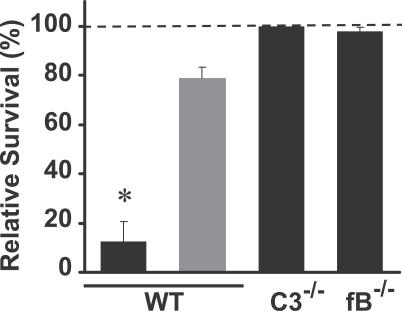

Hi-Enhanced Killing of Sp Requires Opsonization Involving the Alternative Pathway of Complement and Recognition by Mac-1 (CD11b/CD18)Neutrophil-enriched PECs were obtained from mice following i.p. administration of heat-inactivated whole Hi636 in casein. The effect of HKHi on the ability of neutrophil-enriched PECs to kill Sp1121 is shown relative to controls where neutrophil-enriched PECs were elicited by casein administration alone. Survival of Sp1121 was assessed over a 45-min incubation with complement in serum from wild-type mice (WT), C3-deficient mice (C3−/−), or factor B–deficient mice (fB−/−) as indicated. Neutrophil-enriched PECs were obtained from Mac1−/− (grey bar) or control C57Bl/6 (black bars) mice. No stimulation of killing was observed in controls using heat-inactivated complement or cells from animals pretreated with monoclonal antibody RB6-8C5 to deplete neutrophils. Values represent ≥ three independent determinations in duplicate ± SD. *p < 0. 01 compared to other conditions.